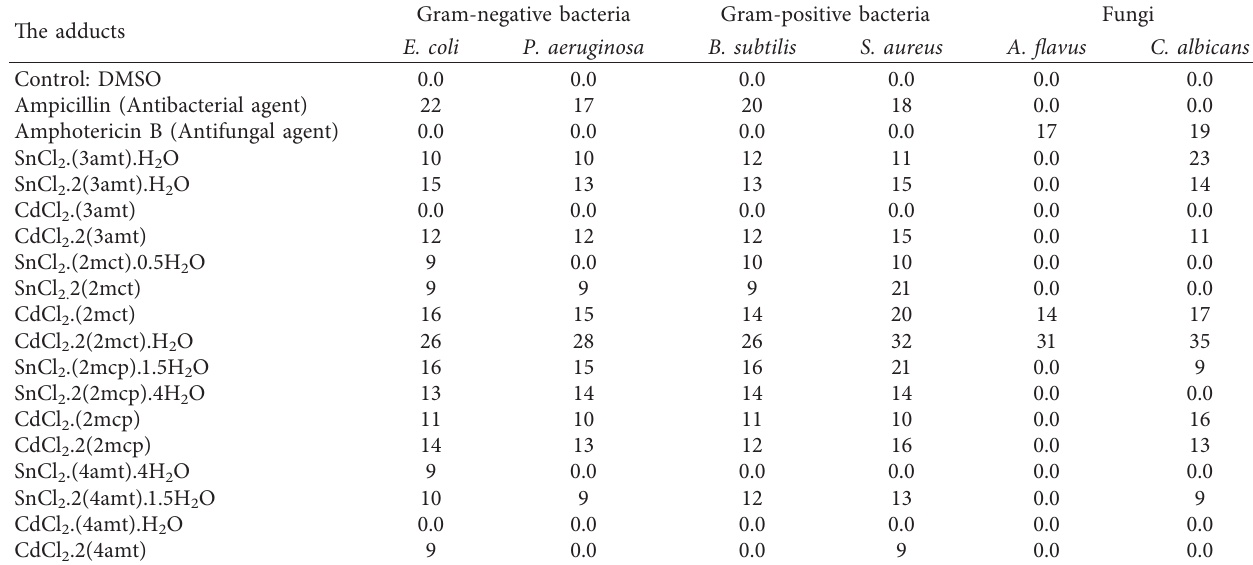
Table 7: Antimicrobial activities (inhibition zone diameter, mm/ µ g sample) of papaverine and its metal complexes against Gram-positive bacteria, Gram-negative bacteria, and two types of